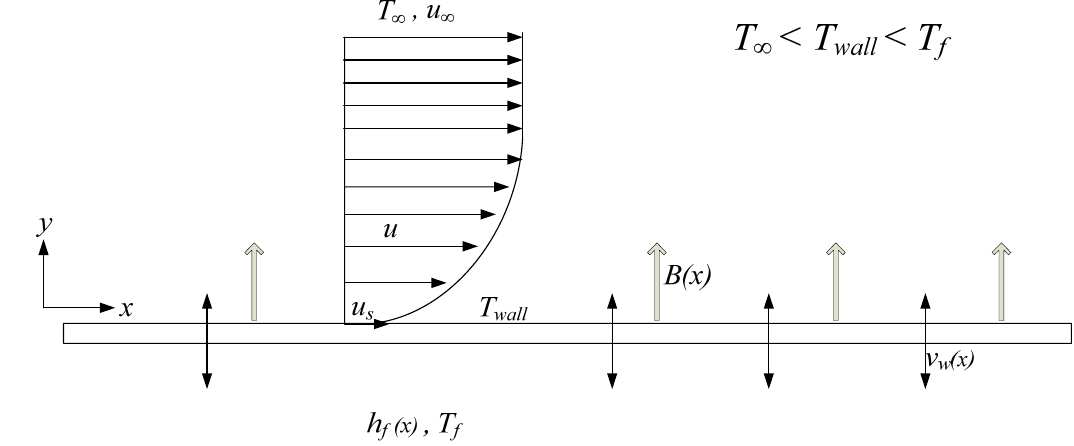
Figure 1. Physical model of flow and heat transfer in the present